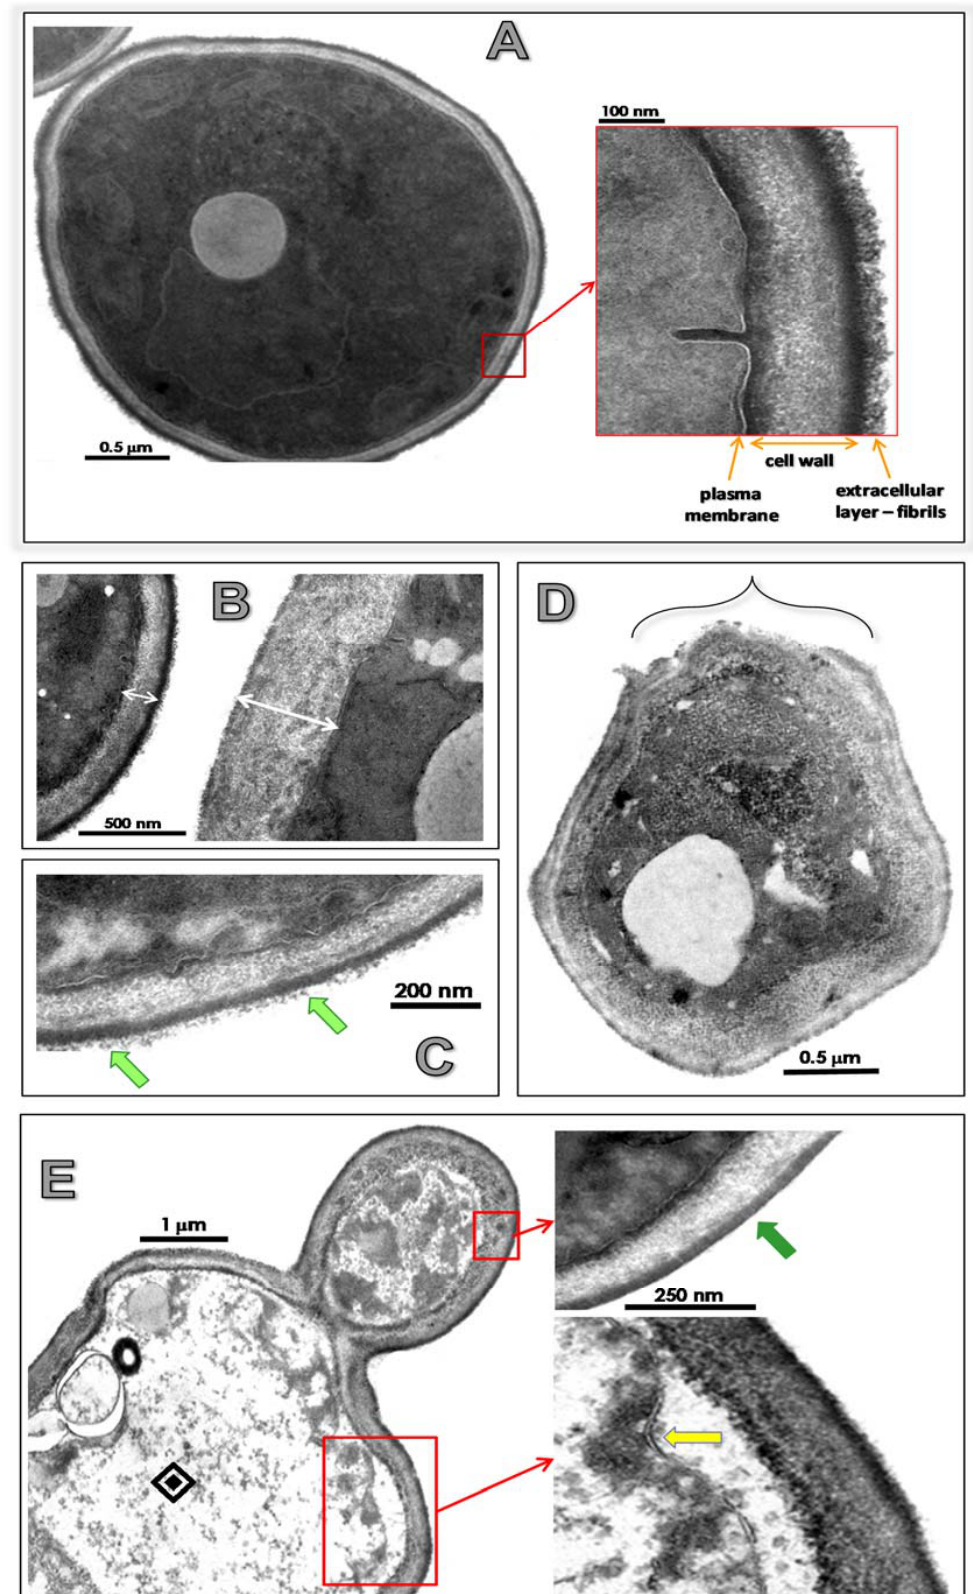
Figure 4. Effects of lopinavir on the ultrastructure of C. albicans yeast cells. ( A ) Untreated and ( B – E ) lopinavir (100 and 200 µM)-treated fungal cells were processed and analyzed by transmission electron microscopy. ( A ) Control yeasts present a